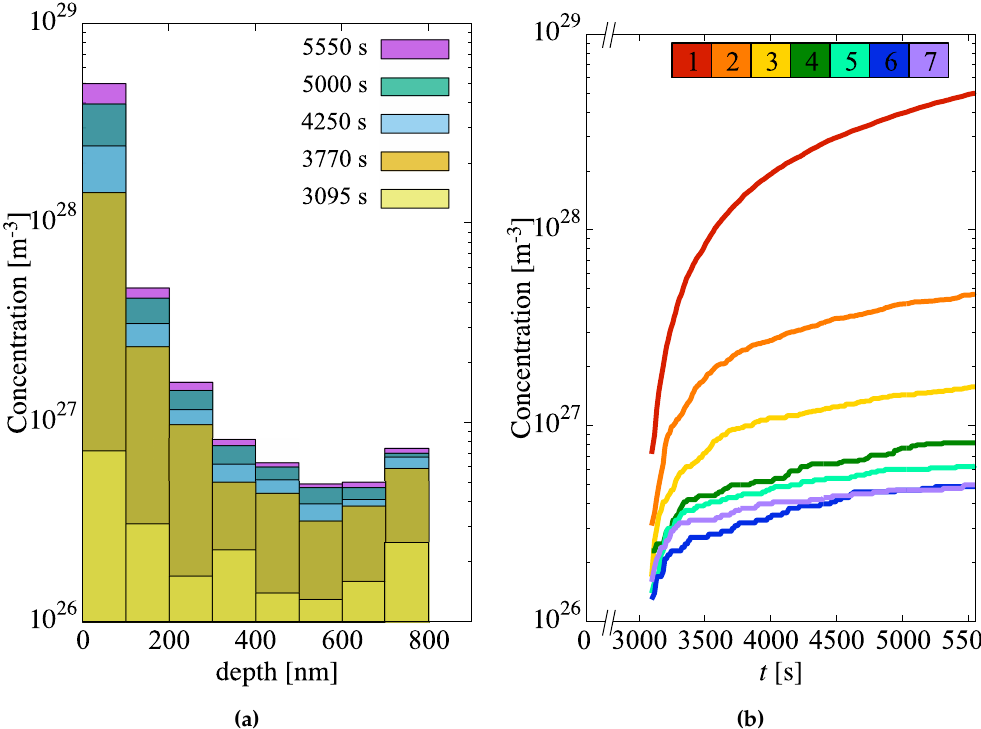
Figure 7. ( a ) Concentration of incipient hydride nuclei in the metal layer as a function of depth for several time snapshots. ( b ) Hydride concentration buildup as a function of time for each depth element. Each curve is colored according to the key at the top of the figure (element 1 is closest to the oxide/metal interface). Per Table 3, each element is 100-nm